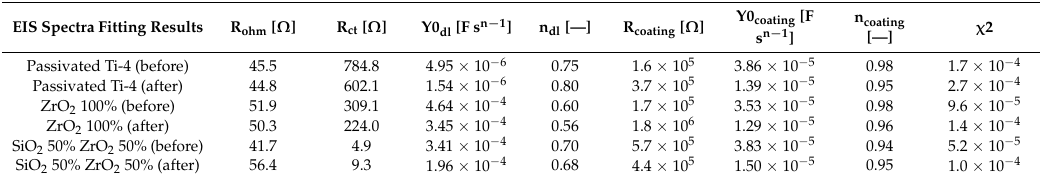
Figure 8. Electrochemical impedance spectra acquired in a DPBS + BSA electrolyte, before and after the potentiodynamic polarizations, on the bare passivated Ti-4 disk and on disks coated with 20 wt.% SiO 2 /ZrO 2 , 33 wt.% SiO 2 /ZrO 2 , 50 wt.% SiO 2 /ZrO 2 and pure ZrO 2 : Overall and zoom. ( a ) spectra acquired before the polarizations; ( b ) spectra acquired after the polarizations. Table 4 . Results of the fitting procedure performed on the impedance spectra adopting a R(CPE-R)(CPE-R) equivalent circuit.